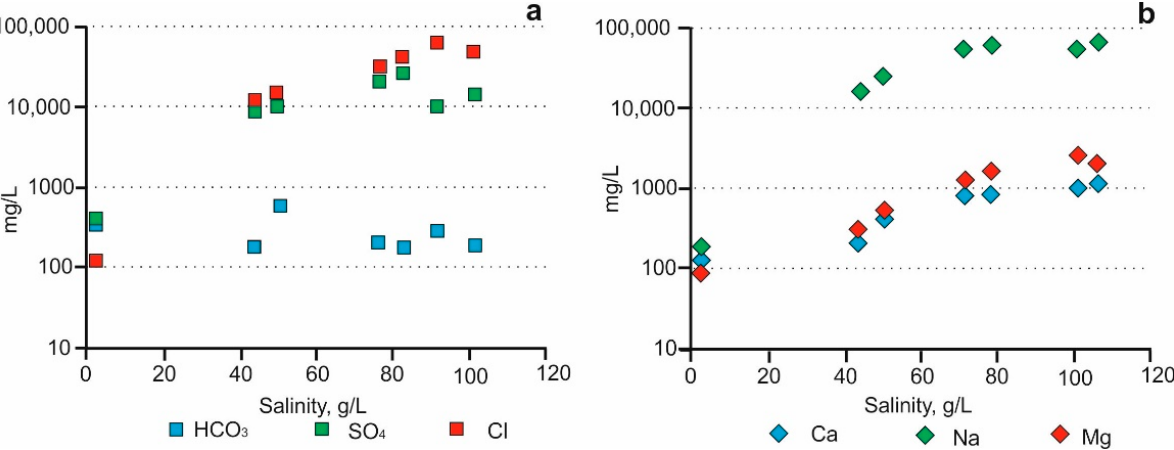
Figure 6. Dependence of basic anions ( a ) and cations ( b ) on water mineralization.